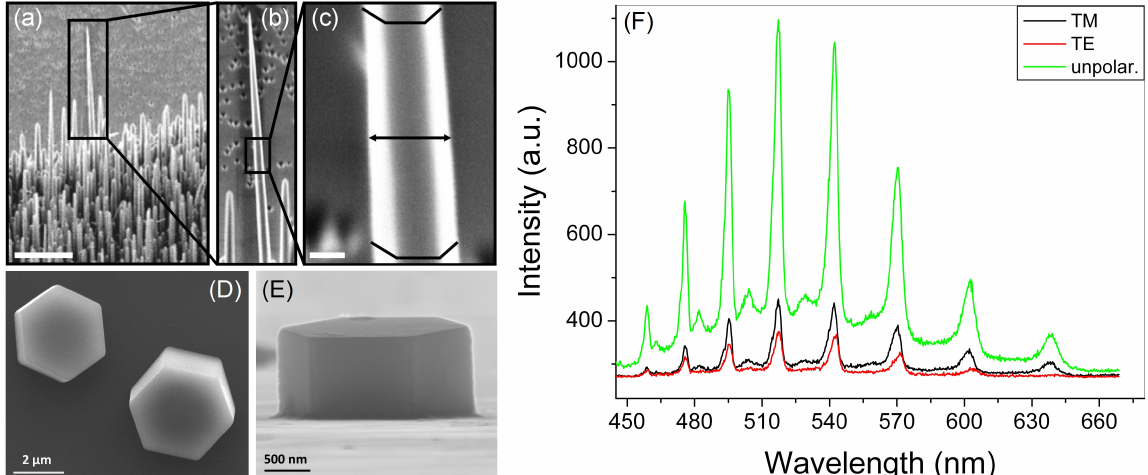
Figure 5: (A) SEM image of an array of ZnO nanoneedles containing the reported one marked by a black rectangle. The scale bar has a length of 10 µ m. (B) Larger scale SEM image of the investigated nanoneedle. The needle’s diameter is continuously tapered approaching zero at the top. (C) High resolution SEM image indicating the hexagonal cross section of the needle. The scale bar has a length of 300 nm. (D, E) SEM image of ZnO microdisks. (F) Polarization-resolved µ -PL spectra of an individual ZnO microwire, the topmost, green curve is unpolar- ized. The spectra detected for TM and TE polarizations are shown in the lower two curves. Reproduced with permission from Ref. [71] (A–C), [75] (D, E), and [80] (F). SEM: secondary electron microscope; TM: transverse magnetic; TE: transverse electric.